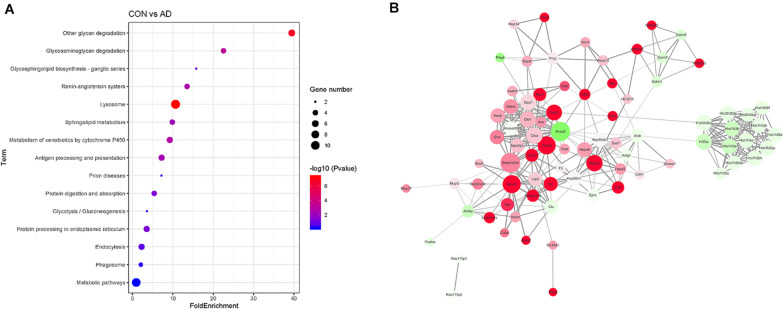
Comparison of the proteomics analysis by KEGG pathway and PPI network analysis. (A) Kyoto Encyclopedia of Genes and Genomes (KEGG) pathway analysis (the top 15 proteins with the greatest fold enrichment are shown). Dot plots of enriched KEGG pathways in differential proteins. The x axis shows the fold enrichment of each KEGG pathway, whereas the color denotes the P-value and the area of the dots represents the number of genes assigned to each KEGG pathway. The y axis displays KEGG pathway term. (B) PPI analysis showed the differential proteins are involved in different network. Red indicated upregulated genes, and green indicated downregulated genes in the present study.